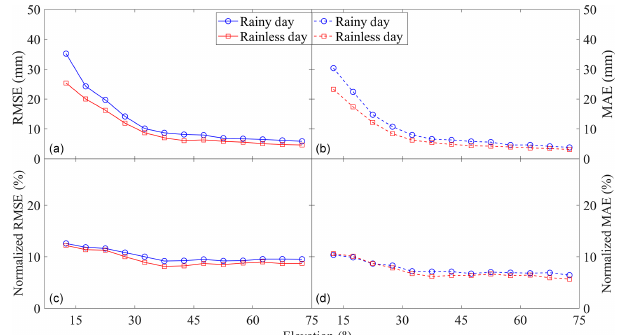
Figure 6. Histogram for MAE (a) and RMSE (b) of SWV residuals (differences between the tomography-computed SWV and GAMIT- estimated SWV) for the KYC1 station, which has not been used in the tomographic modelling (blue for rainy days, red for rainless days).